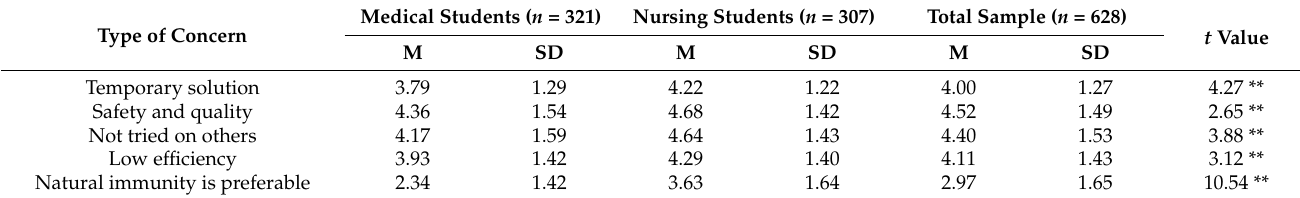
Table 4. COVID-19 vaccine concerns among medical and nursing students ( n = 628). Type of